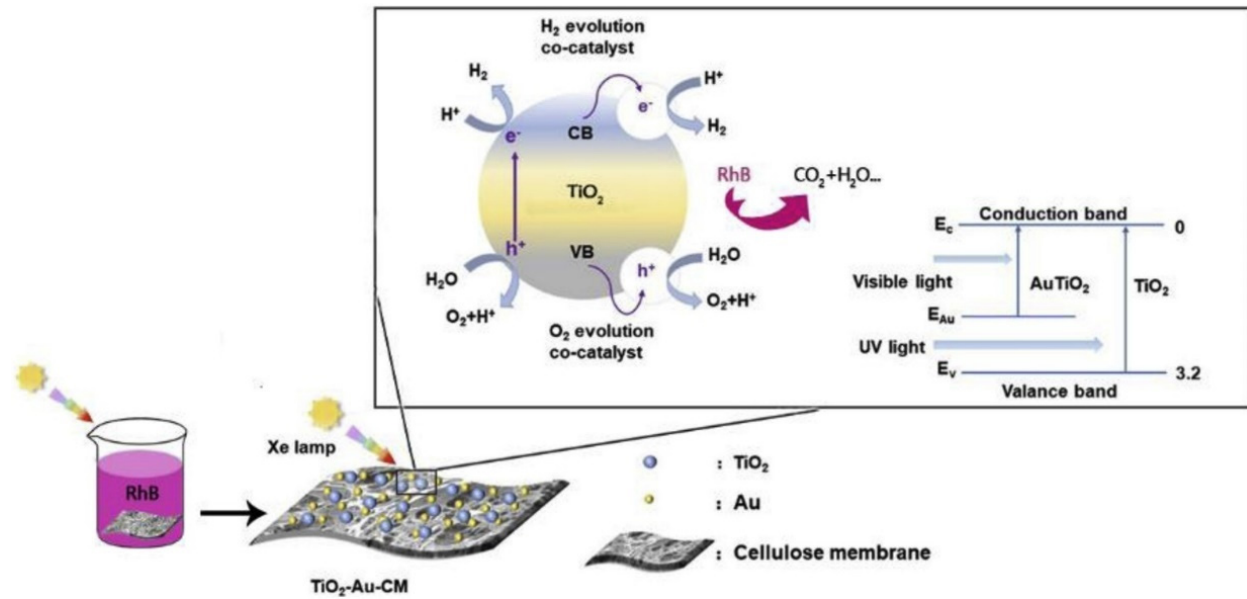
Figure 3. Schematic image for the mechanism of photoinduced charge carrier transfers in TiO 2 -Au cellulose membranes under solar irradiation. Reprinted with permission of Reference [26].